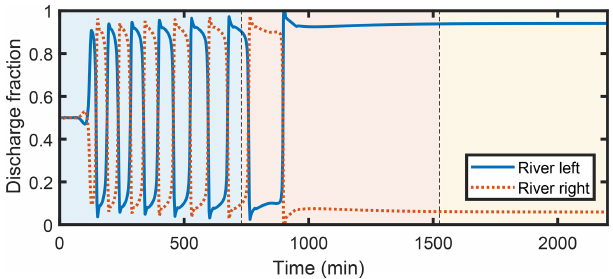
Figure 3. Typical water discharge partitioning time series obtained from the SPV model. Background colors represent the prograda- tional, transitional, and bypass portions of the